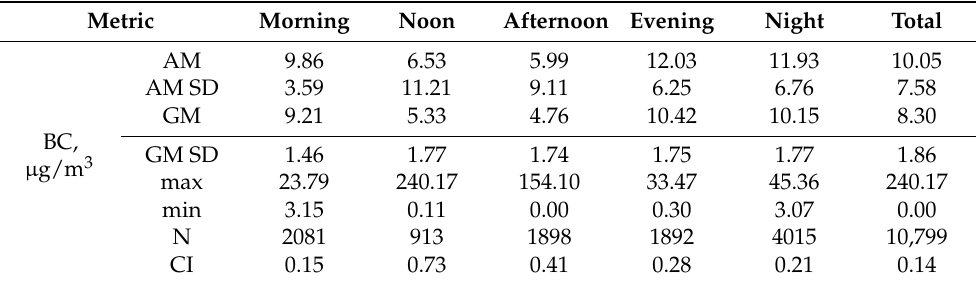
Table A3. Daily integrated exposure dose to BC in different MEs in Trivandrum on representative days.